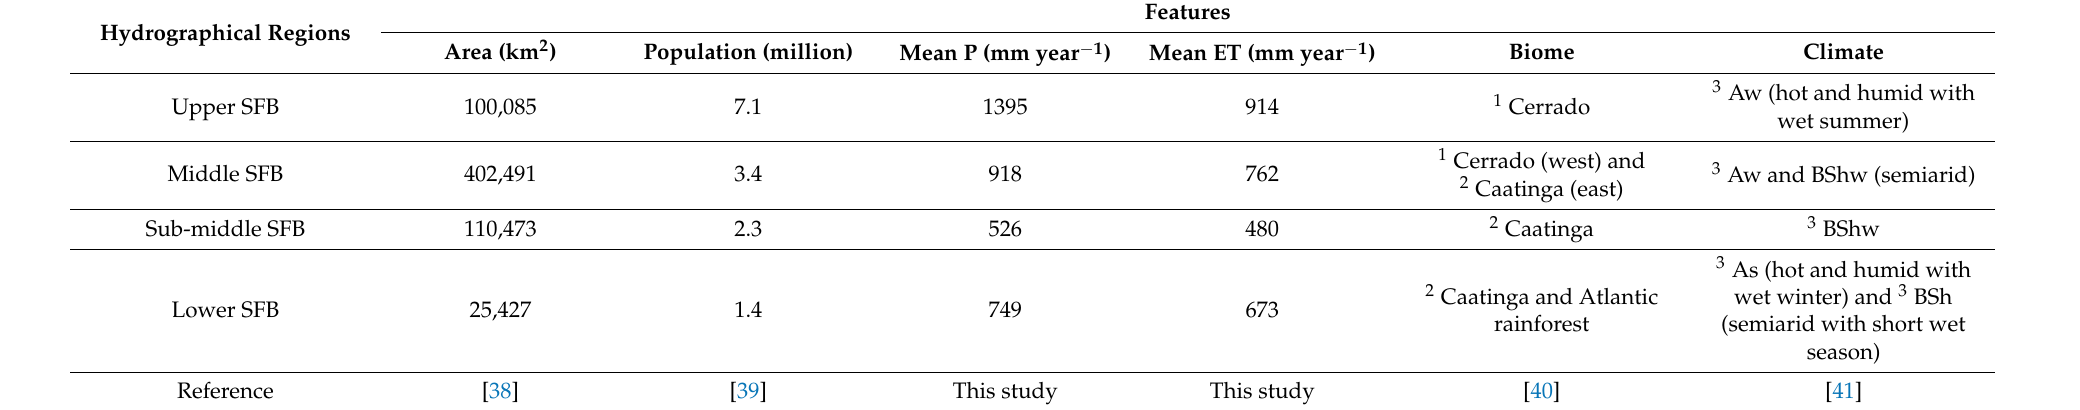
Table 1. The main features of the hydrographical regions of the Sao Francisco River Basin